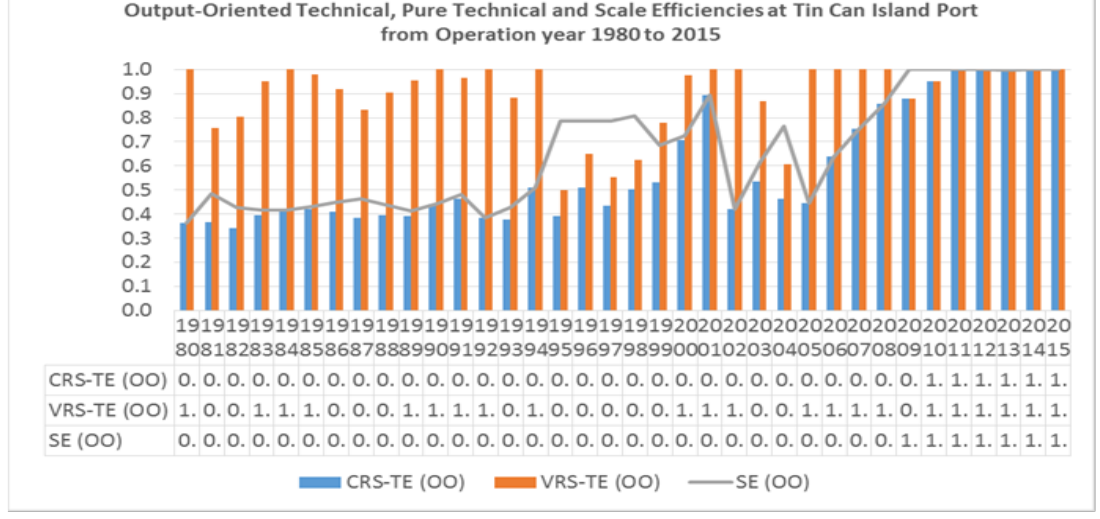
Figure 4: CRS – Technical Efficiency (Output-oriented) and CRS – Scale Efficiency (Output- oriented) at Tin Can Island Port Complex from 1980 –